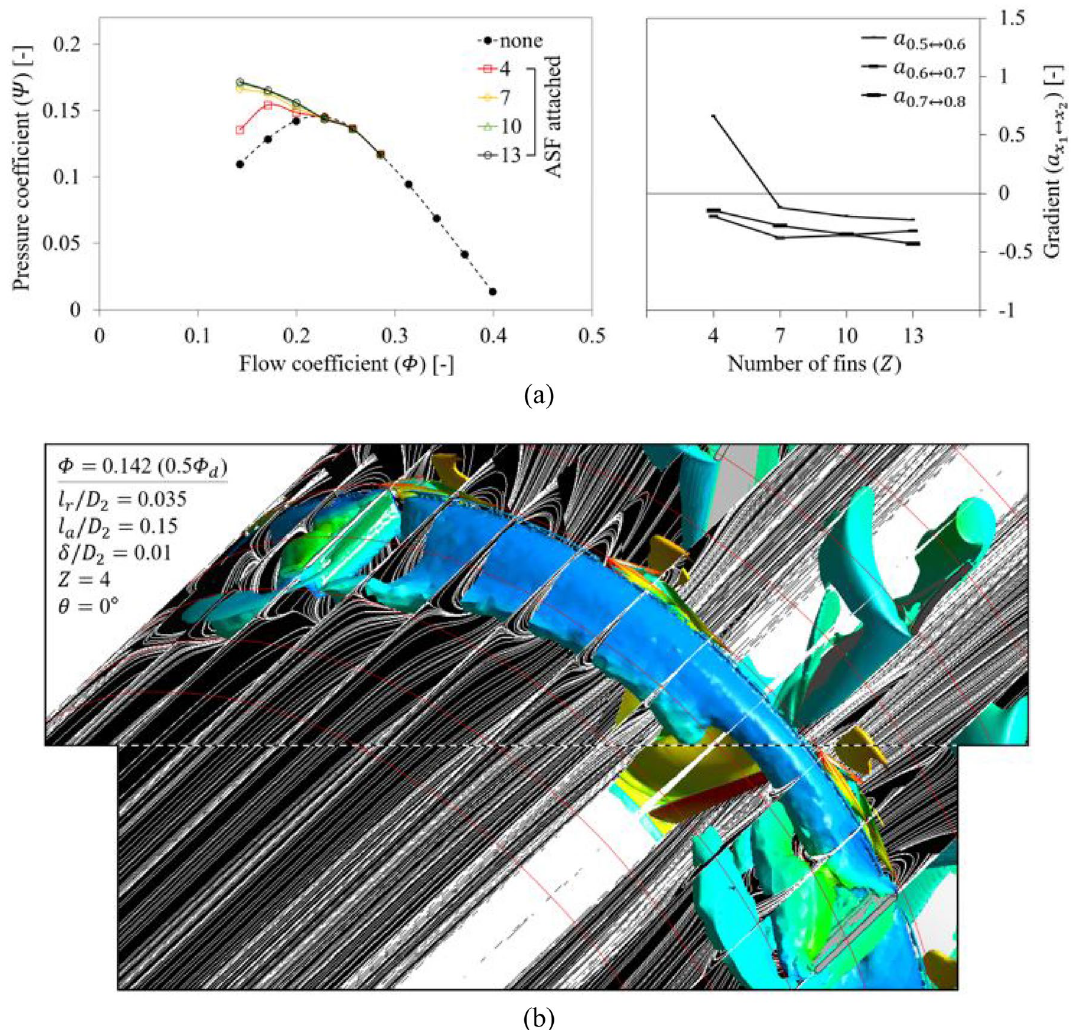
Figure 17. Evaluation for number of fins ( Z ) of ASF: ( a ) Q - P curve (left) and the gradient (right) in each flow rate range; ( b ) Internal flow field for Z = 4 at 0.5 Φ d